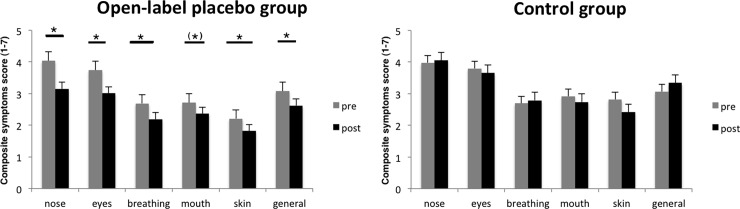
Changes of allergic symptoms for open-label placebo and control group for single symptom groups (mean and standard error).Results show significant improvements for the open-label placebo group but not for the control group. * p < 0.05, (*) p = 0.06.